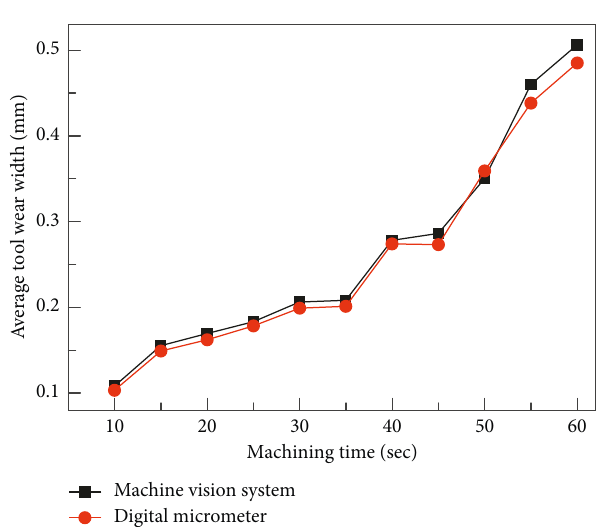
Figure 6: Graph comparing the digital microscope and the vision system measurements of average tool wear width.